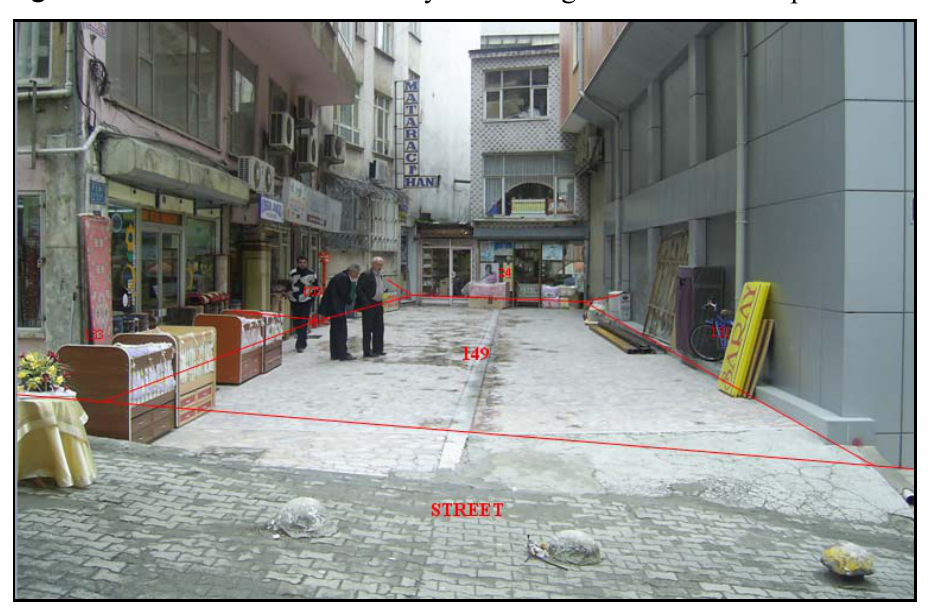
Figure 4 . Parcel 149 was formed by excavating from underneath parcel 131.